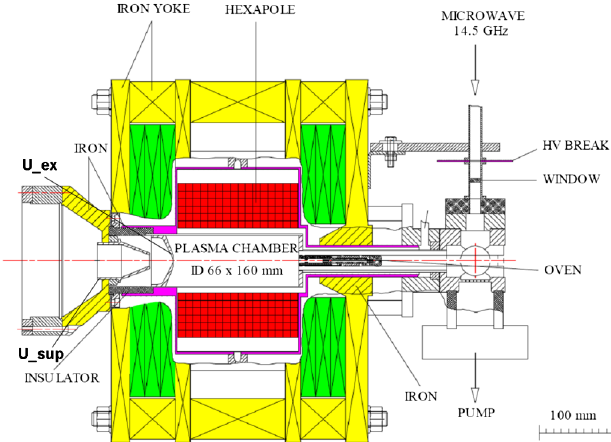
FIG. 2. ECR source at GSI with a permanent hexapole of 1 Tat the pole tip. The longitudinal magnetic field is 1 T at maximum as well. It has an electron suppressing electrode at a potential of (cid:3) 2 kV . The extraction voltage is set to obtain 2 : 5 keV = u after extraction